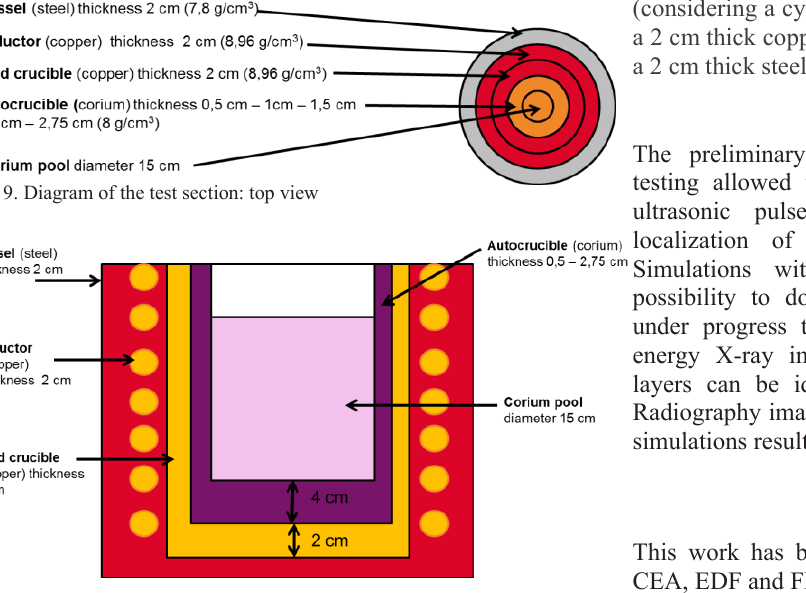
Fig. 10. Diagram of the test section: side view The corium bed cylinder is decomposed into 33 slices of different chemical composition and density. The time evolution of these 33 slices is discretized into 17 configurations describing a temporal stratification process.